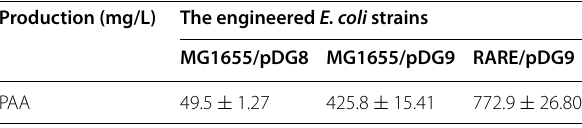
All experiments were performed in triplicate and error bars show SD